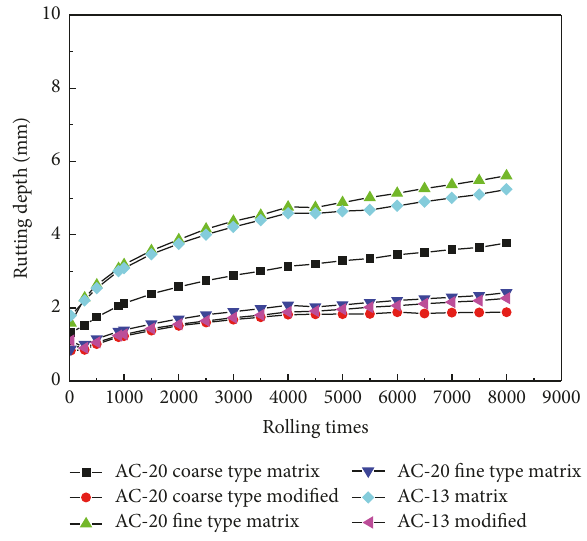
Figure 8: APA rutting depths of asphalt mixtures with 4% air voids at 50 ∘ C under immersing conditions.